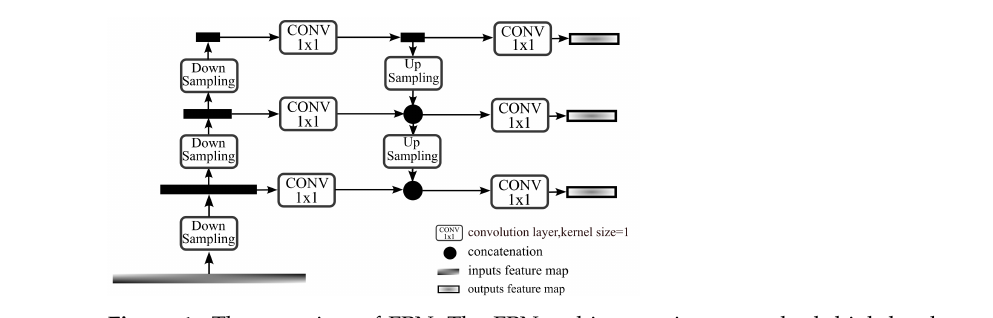
Figure 1. The overview of FPN. The FPN architecture integrates both high-level semantics and shallow details in the form of a feature graph pyramid.